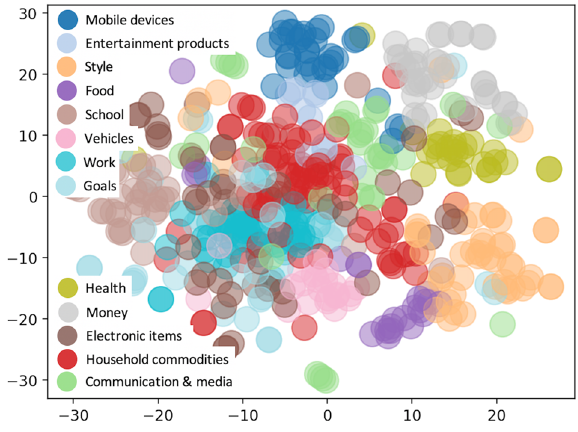
Fig. 5 Cluster visualization of keywords in ACHIEVEMENT. The keyword clusters show the relevance of consumer products and